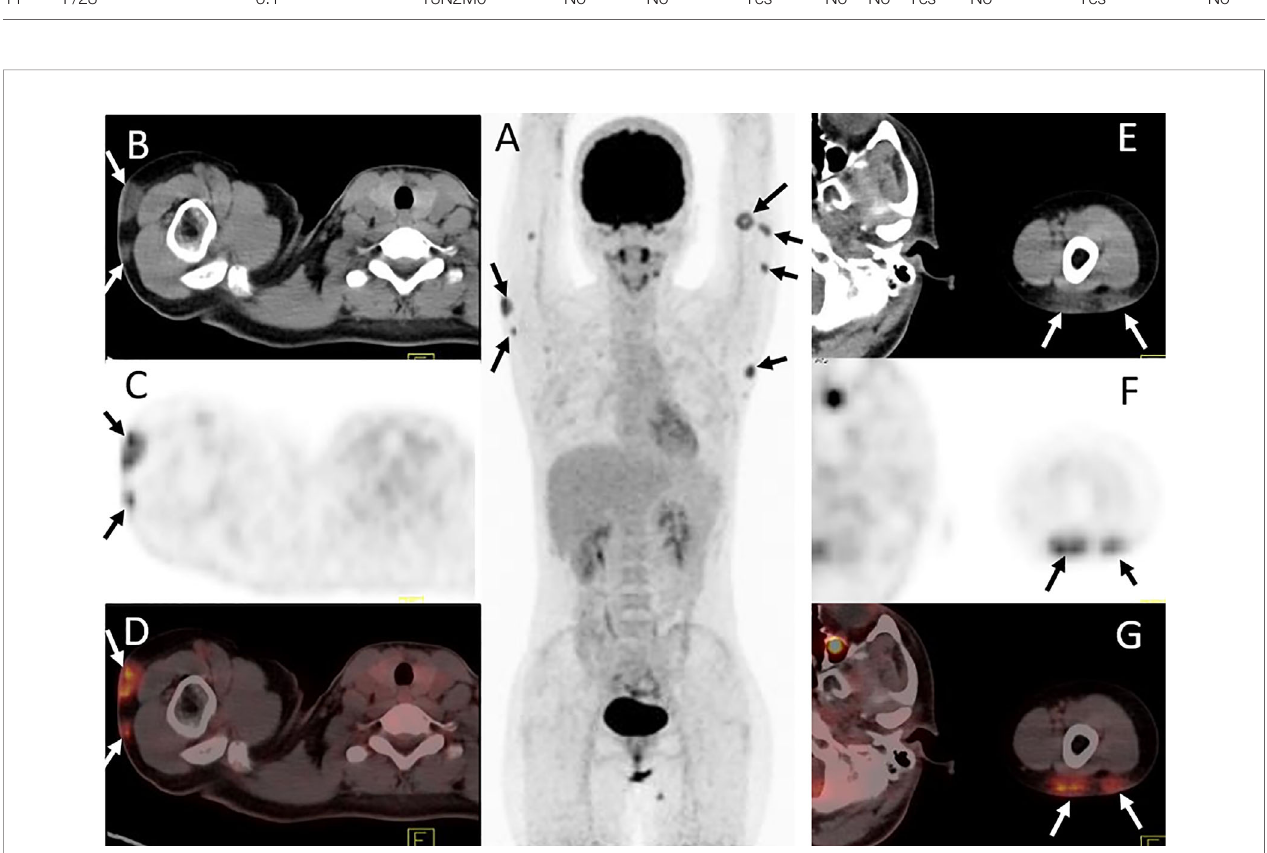
FIGURE 3 | Twenty-four-year-old female with subcutaneous panniculitis-like T-cell lymphoma. Three-dimensional maximum intensity projection image (A) , axial CT (B, E) , corresponding PET (C, F) and fusion PET/CT (D, G) images from 18 F-FDG PET/CT clearly show multiple intensely 18 F-FDG-avid subcutaneous in fi ltrative nodules in both upper arms with poor or well de fi ned borders (arrows), representing sites of